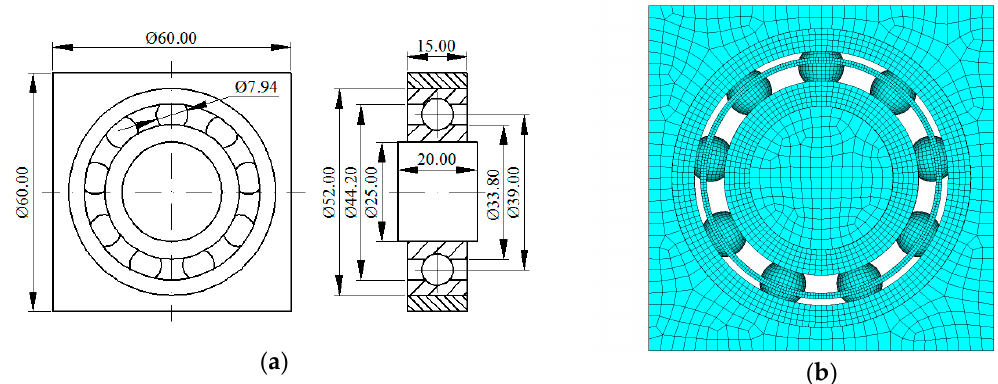
Figure 2. The geometrical dimension and finite element method (FEM) model of a bearing: ( a ) the geometrical dimension and ( b ) the FEM model.